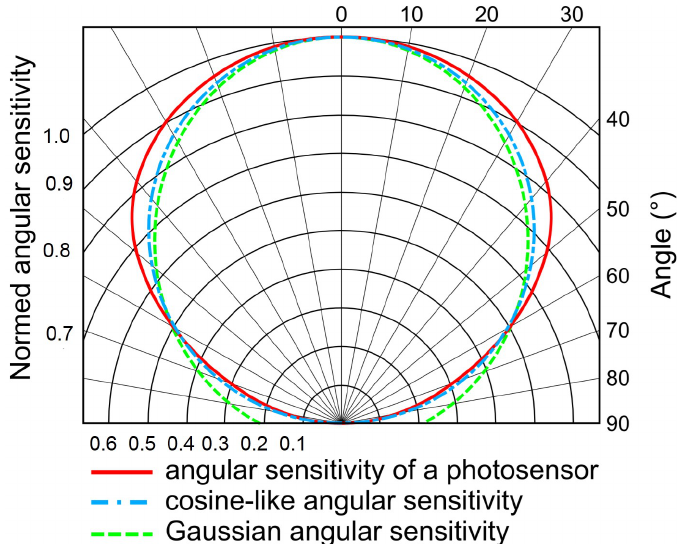
Figure 6. Comparison between the angular sensitivity of a photosensor embedded on HyperCube (red solid line) and the cosine-like angular sensitivity of the model (blue dashed dot line) given by Equation (2) and the Gaussian angular sensitivity (dashed green line) given by Equation (1) with the acceptance angle ∆ ρ =